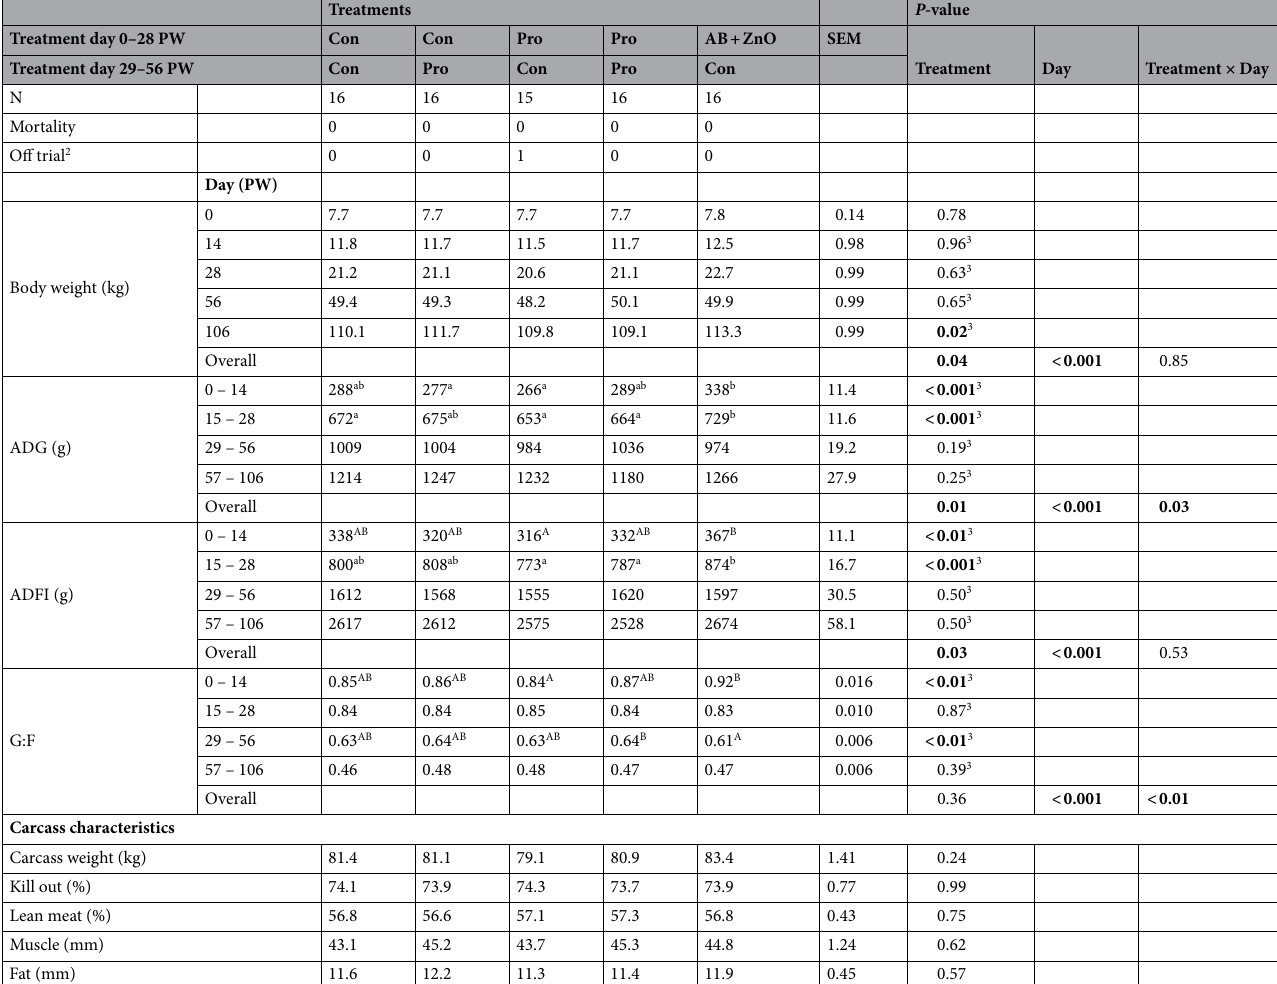
Table 1. Effect of Bacillus altitudinis WIT588 spore supplementation to 1st stage and/or 2nd stage weaner diets and antibiotic (AB) + ZnO supplementation to 1st stage weaner diets on post-weaning growth and carcass characteristics 1 . PW, post-weaning; Con, control; Pro, Probiotic, AB + ZnO, antibiotic + zinc oxide. 1 Least square means and pooled standard errors of the mean (SEM). 2 Off trial: Pig was removed from experiment due to lameness. 3 P -values represent simple main effects obtained using the Slice option. a–b Values within a row that do not share a common superscript are significantly different after Tukey adjustment for multiple comparisons ( P ≤ 0.05). A–B Values within a row that do not share a common superscript tended to differ after Tukey adjustment for multiple comparisons ( P ≤ 0.10). Data were analysed as repeated measures using the mixed model procedure in SAS with the pig being the experimental unit. Differences in least square means were explored using the t -test after Tukey adjustment for multiple comparisons. The Slice option was used to obtain Simple Main Effects. P -values which are less than or equal to 0.05, and therefore denote significant differences, are shown in